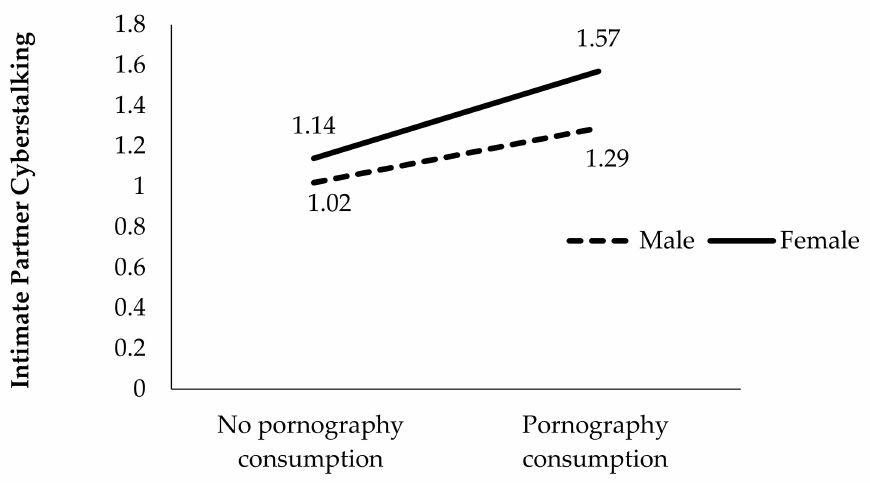
Figure 2. Moderating effect of gender on pornography consumption and intimate partner